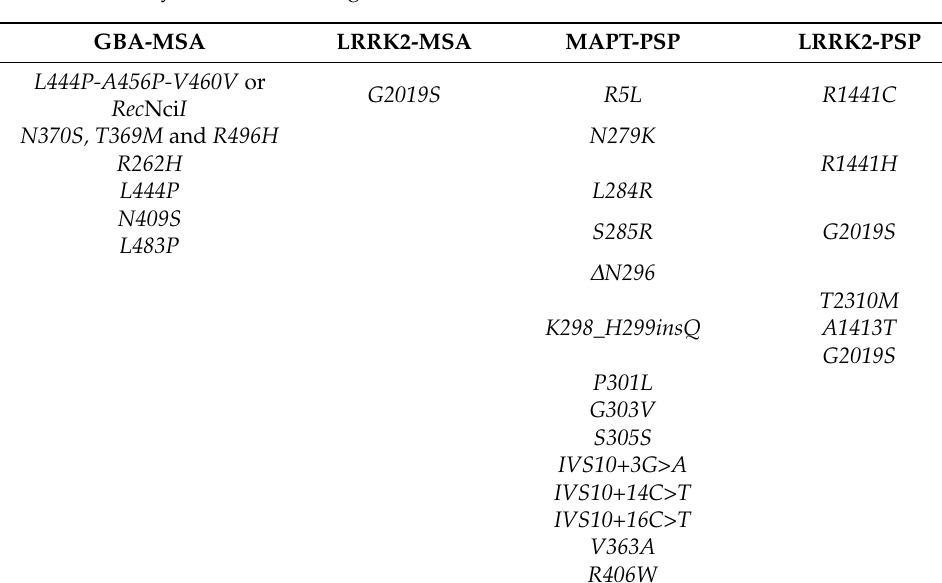
Figure 1. Flowchart of the study selection. Table 1. Summary of MSA and PSP gene